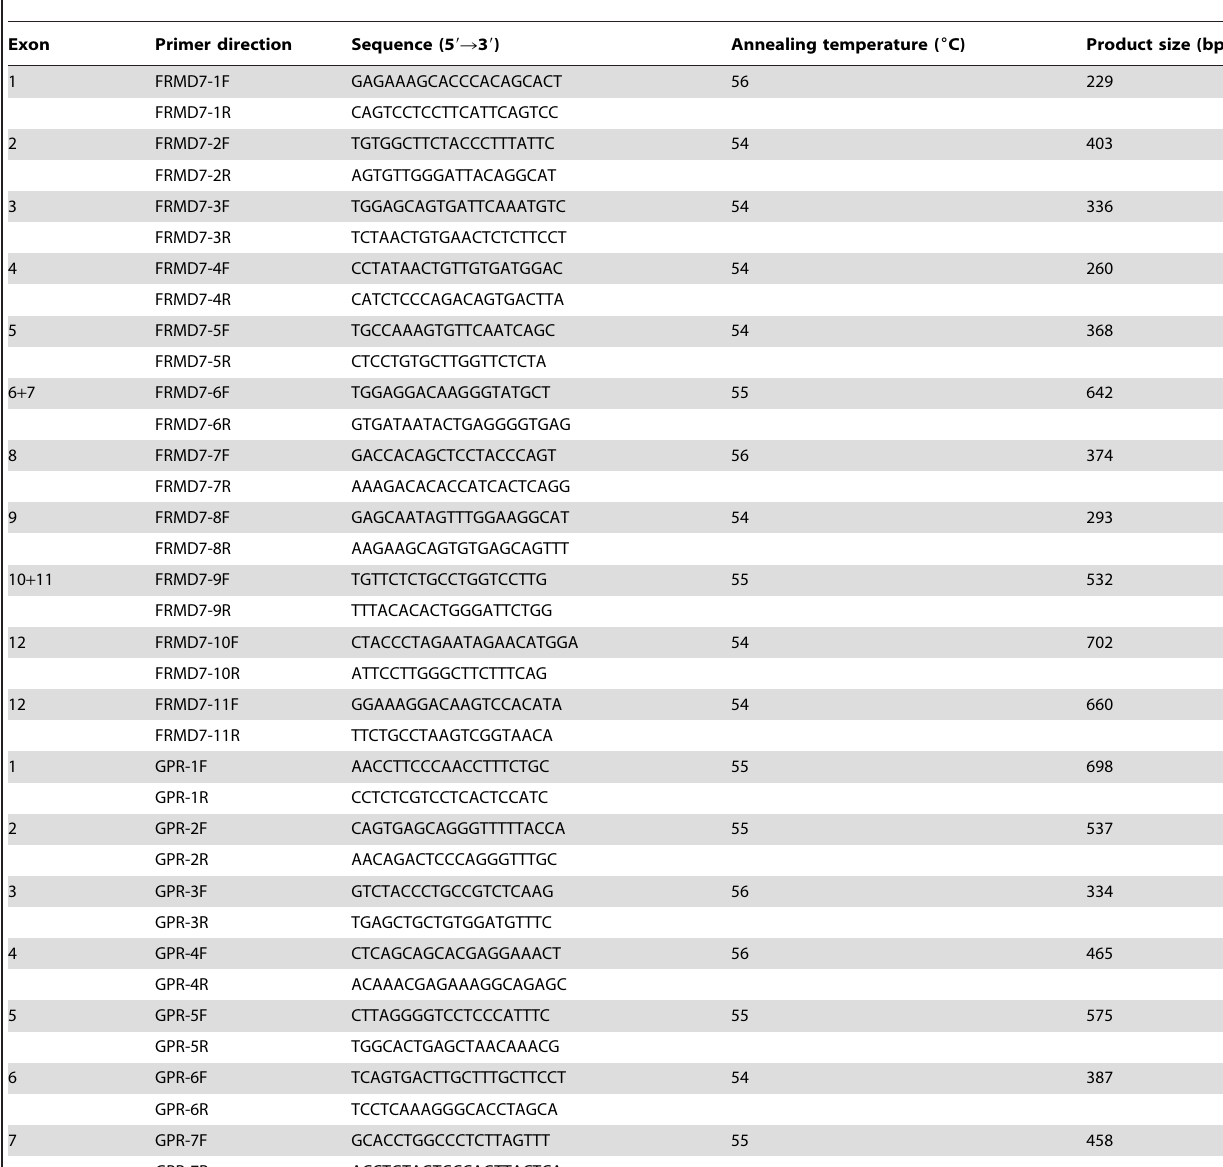
Table 1. Primers used in PCR for amplification of FRMD7 and GPR143